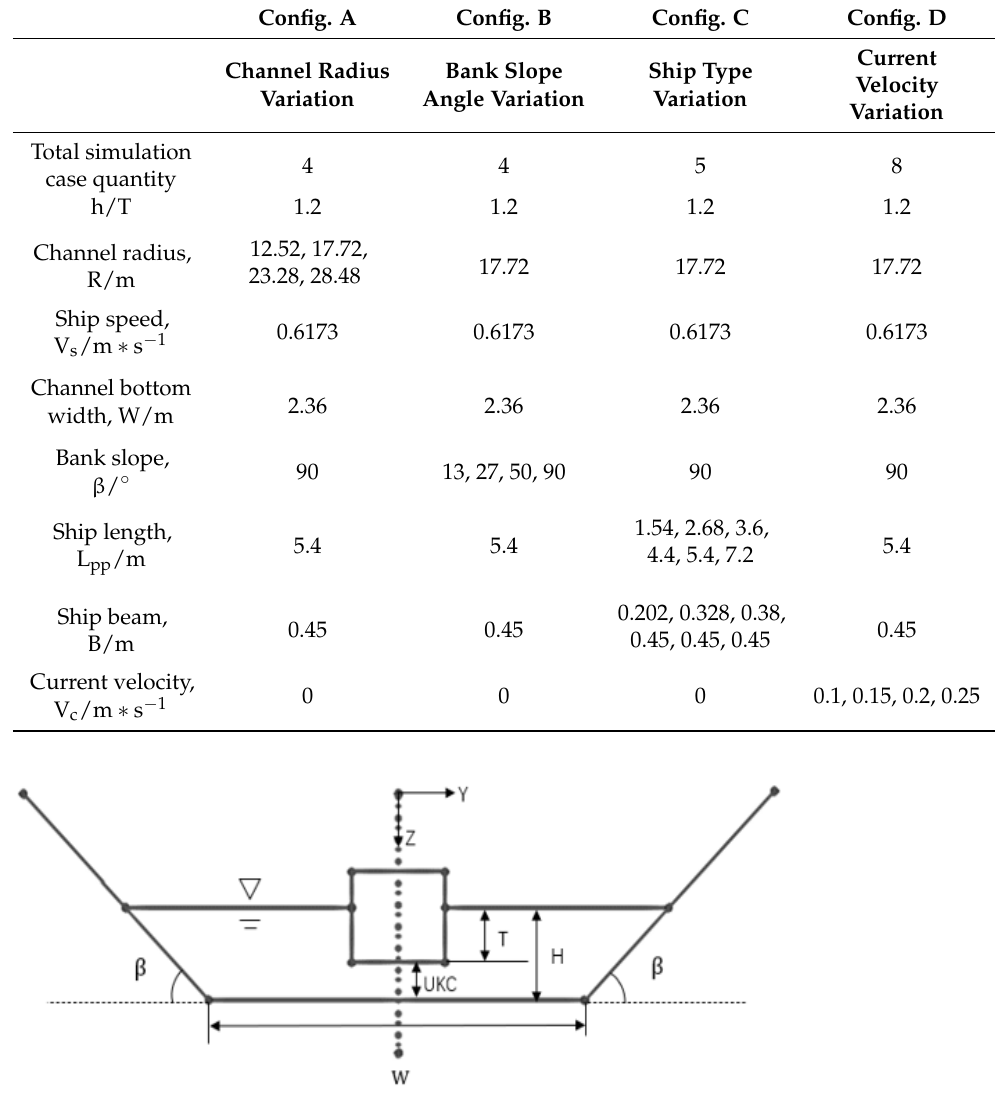
Figure 1. Cross section view of the curved configuration.